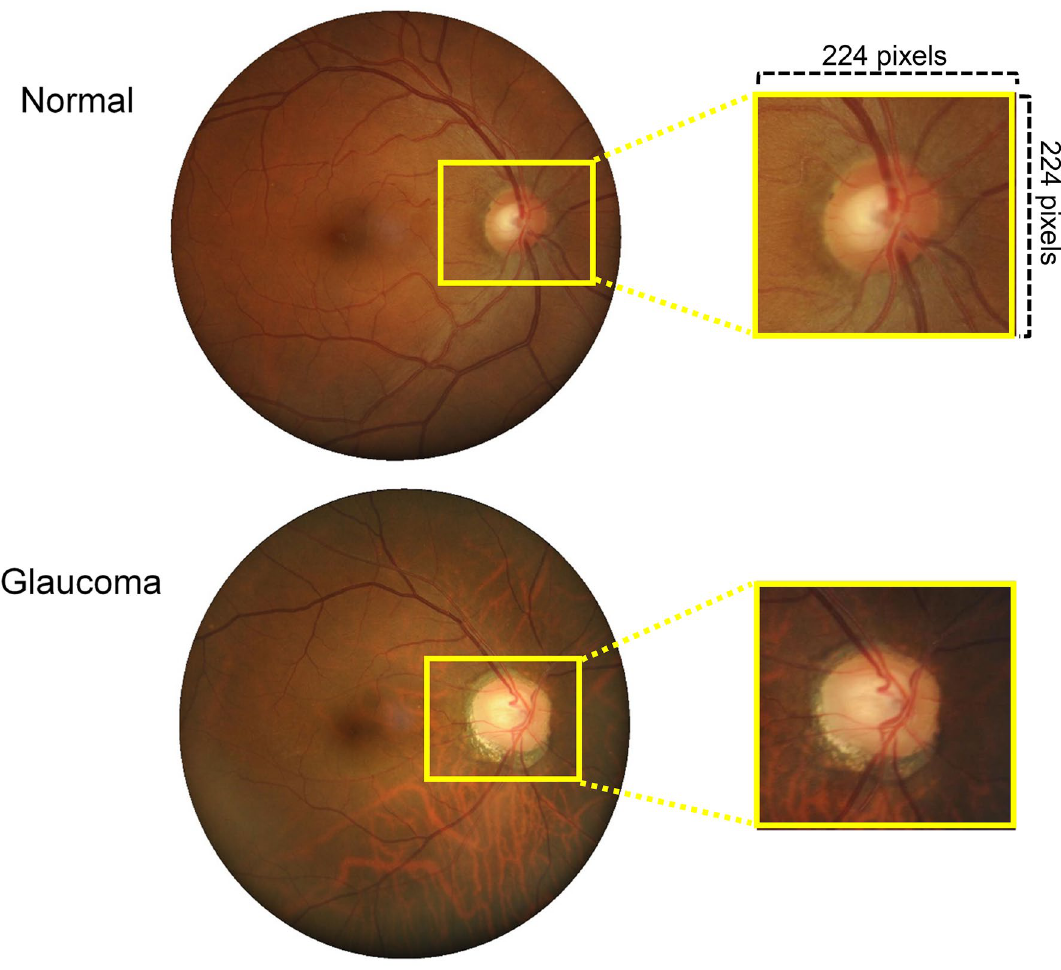
Figure 1. Examples of the original and cropped fundus images. All images were labeled as normal or